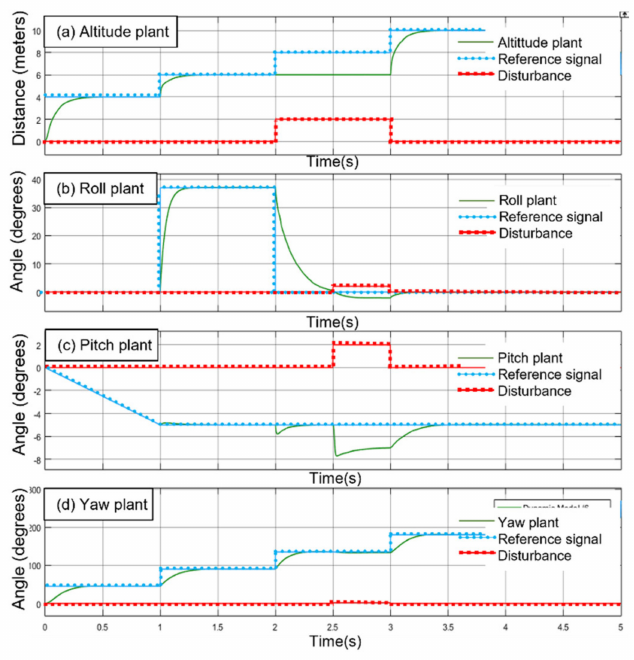
Figure 17. Autotuned GA–PID simulation results. ( a ) Altitude plant, ( b ) roll plant, ( c ) pitch plant, ( d ) yaw plant.